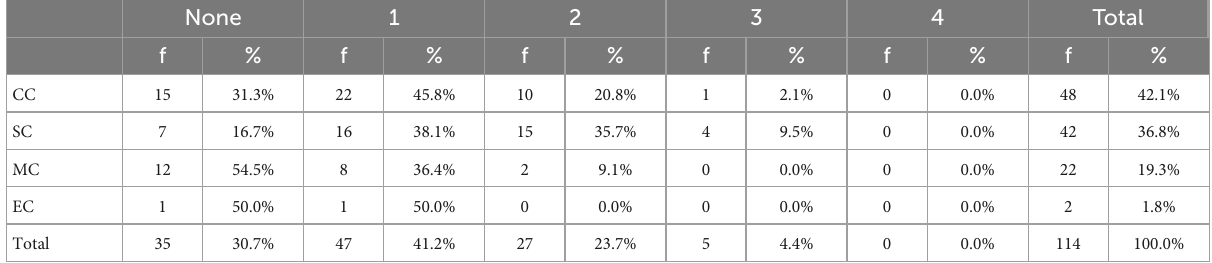
TABLE 5 Differences in synchronized physiological arousal episodes frequency under different challenges. Non-synchronized physiological arousal